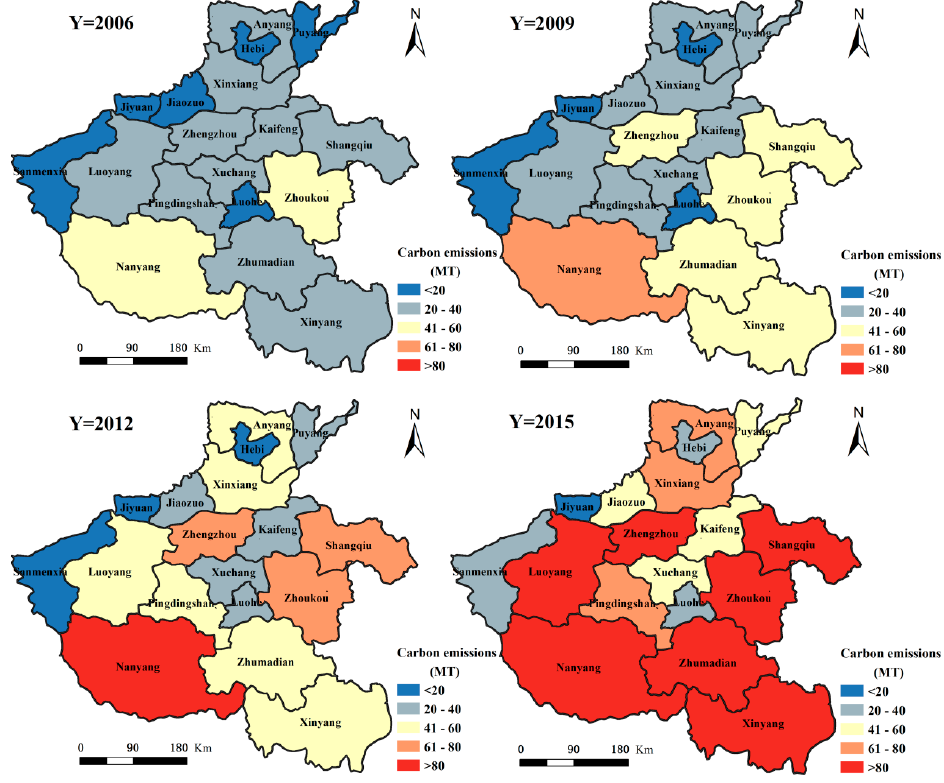
Figure 5. Spatial differences in carbon emissions from the secondary sector in Henan Province during 2006–2015.